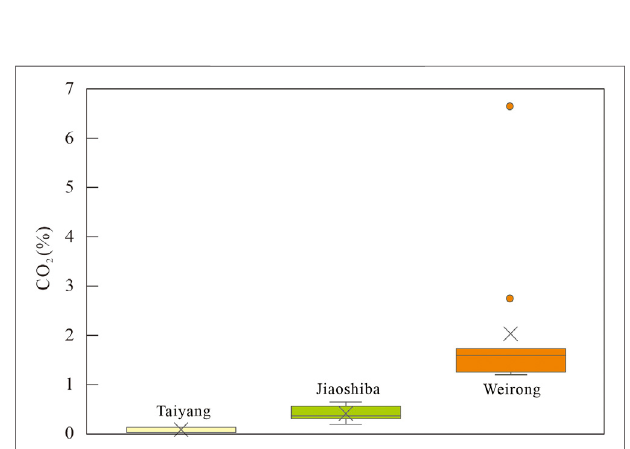
Frontiers in Earth Science |